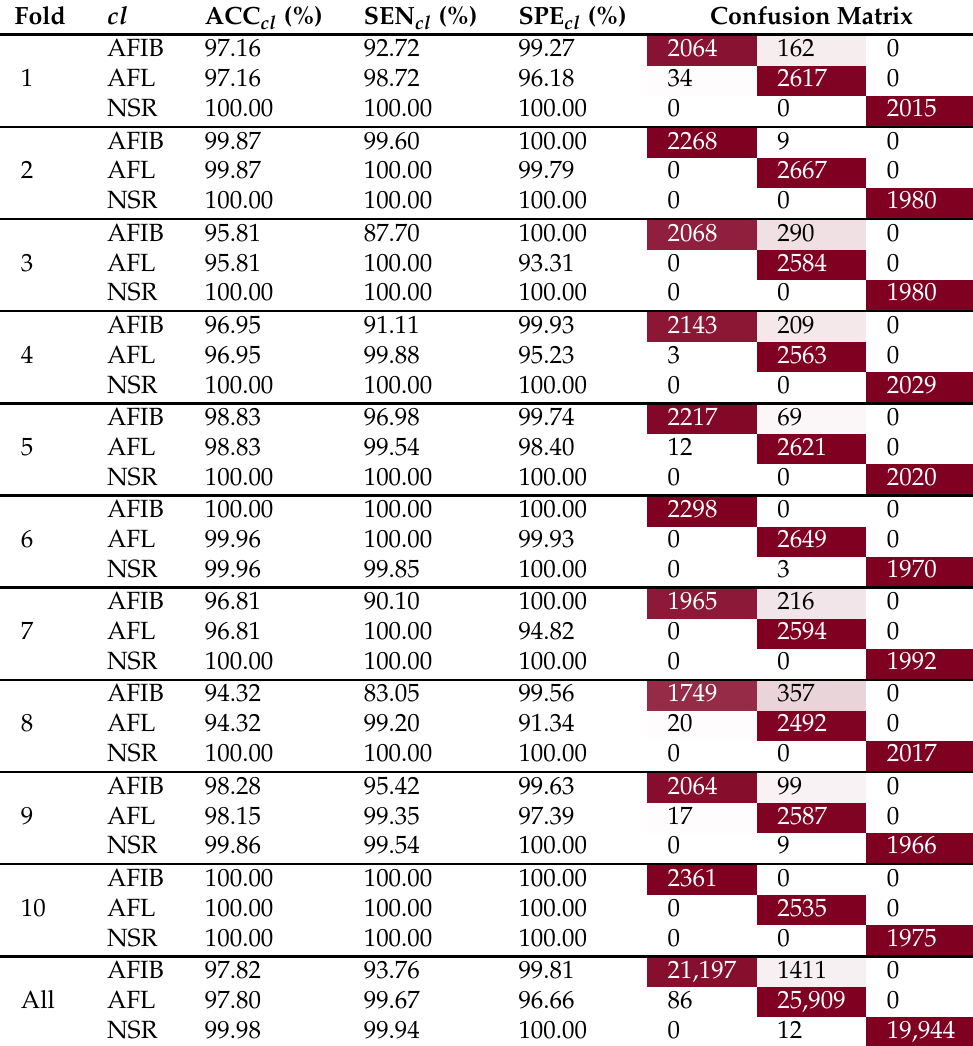
Table 8. Analysis results for the individual and all